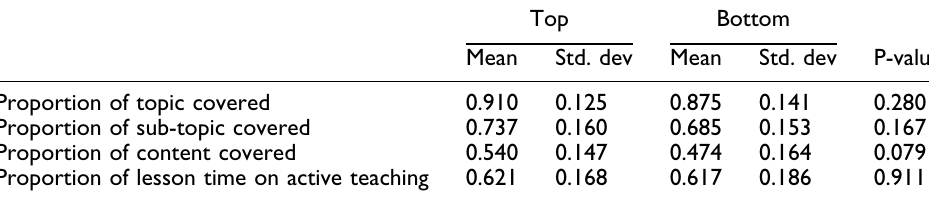
Table 2. OTL and time on active teaching by school category.